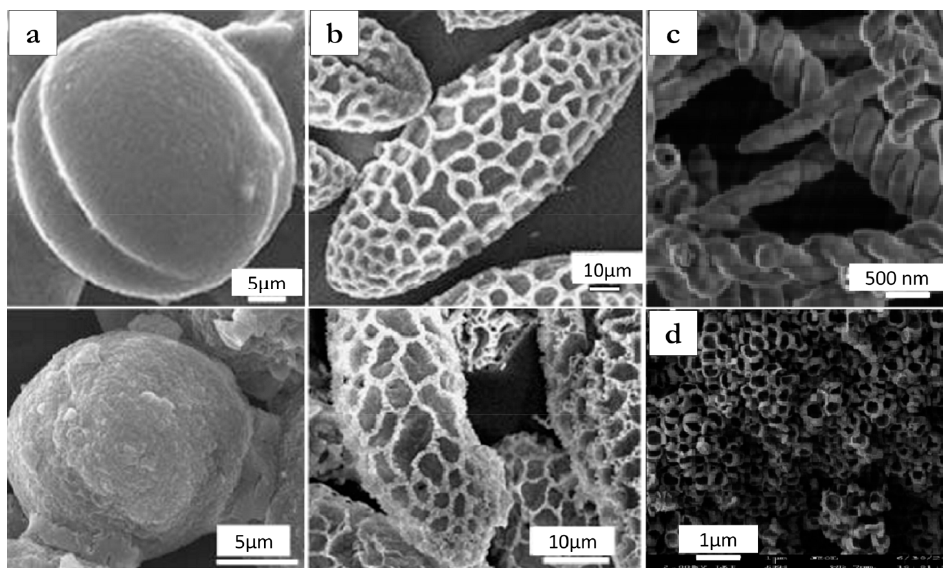
Figure 3. Molecular imprinted materials and their surface structure diversity. SEM images of ( a ) camellia and ( b ) rapeseed pollens (top) with their molecular impressions (bottom) [73] (permission obtained for reproduction); ( c ) chiral helical structure formed by a chiral low molecular weight gelators as templates [76] (Reprinted from Ref. 76 with permission of The Royal Society of Chemistry.) and ( d ) macroporous silica used for biodiesel synthesis where liquid crystalline surfactants and polystyrene beads were used as templates [72] (Reprinted from Ref. 72 with permission of The Royal Society of Chemistry.).